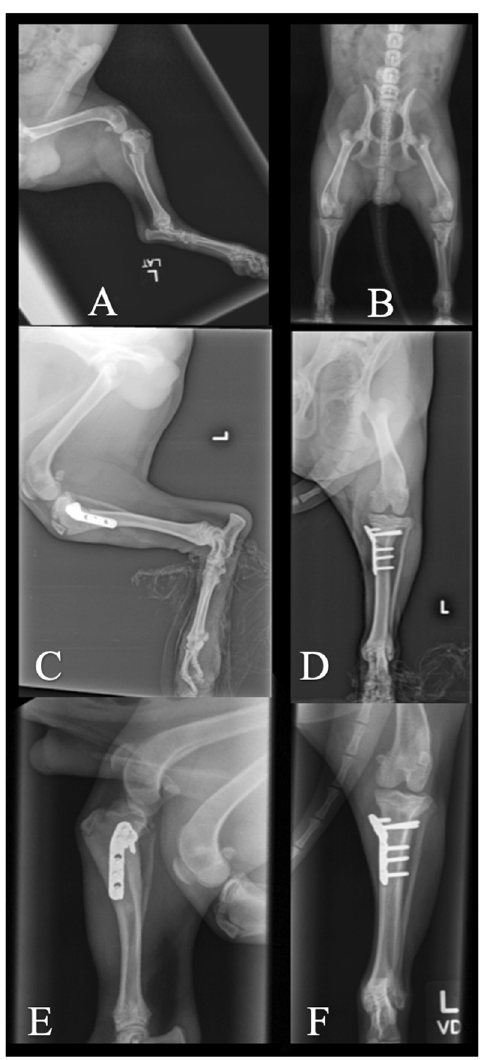
Fig 5. Case 47 managed using a locking TPLO plate. A and B: Mediolateral and craniocaudal views. C and D: Immediate postoperative mediolateral and craniocaudal views. E and F: 4 weeks postoperative mediolateral and craniocaudal